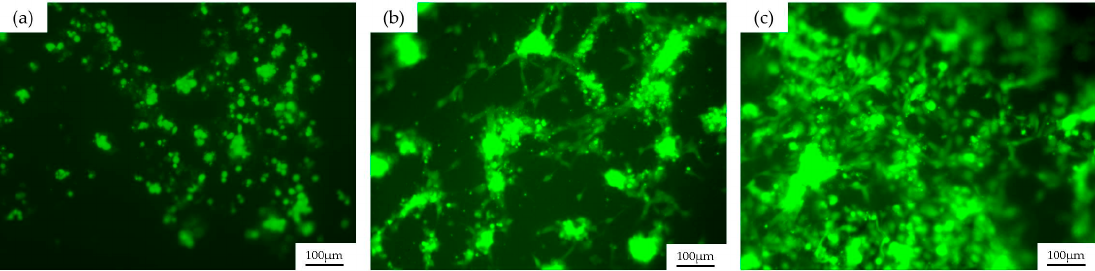
Figure 6. Representative fluorescence microscopy images of the different sol-gel–coated channels with HUVECs stained with calcein AM after a one-day culture. ( a ) PDMS channel with 60MTES/40TEOS coating; ( b ) with 70MTES/30TISP coating; and ( c ) with 80MTES/20TISP sol-gel coating.